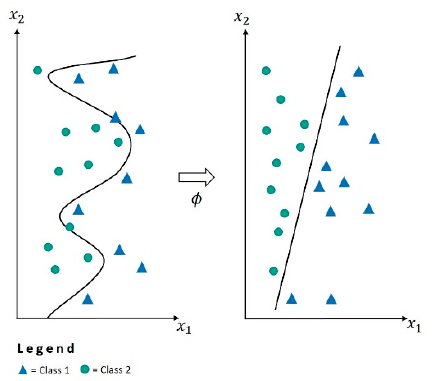
Figure 5. Changing a nonlinear separation to a linear separation in feature space, modified from Deng et al. [50].